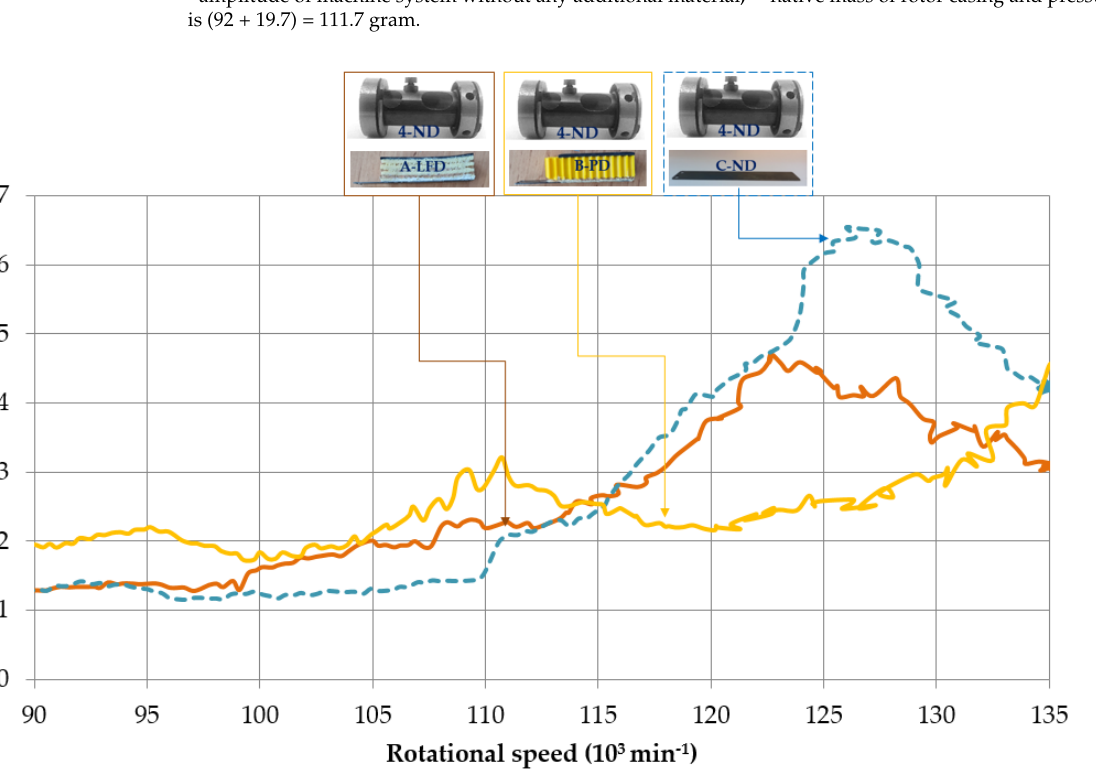
Figure 7. Average amplitudes comparison of pairs of the modified rotor casing and pressure plate. Table 2. Comparison in resonance region through E a . Applying the passive dampers to native rotor casings, the following reduction of vi- bration amplitudes was achieved (Figures 7 and 8, Table 2): The amplitude reduction by 30.2% and 41.5% in a range of 120,000 to 135,000 min − 1 for passive damper A-LFD and B- PD, respectively. A pressure plate with a passive damper A-LFD and original rotor casing 4-ND was able to reduce the maximum amplitude to 4.7g at 122,700 min − 1 (brown in Fig- ure 8). That maximum amplitude value was in safe operation mode as it was below 5g. The presence of the passive damper A-LFD and native rotor casing 4-ND enabled the re- duction of the average amplitude to 3.7g in the abovementioned range (Figure 7). Recall that the original maximum amplitude of 6.5g and the average amplitude of 5.3g of C- ND+4-ND were in warning mode. The addition of passive damper B-PD using native ro- tor casing 4-ND caused the amplitude of 2.6g, i.e., a drop in that amplitude by 59.2% in a rotational speed of 126,000 min − 1 , which is a rotational speed for the original maximum amplitude 6.5g of native design C-ND+4-ND.